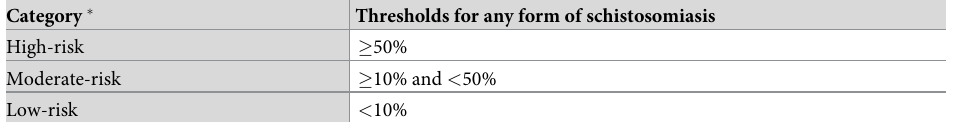
Table 2. Classification of the risk for STHs based on the WHO cut-off values of district-level prevalence. Category � Cumulative prevalence of all STH The % of moderate/heavy intensity infections High-risk � 50% � 10% Moderate-risk � 20% and < 50% < 10% Low-risk < 20% < 10% � Categories and cut-off values listed based on WHO guidelines